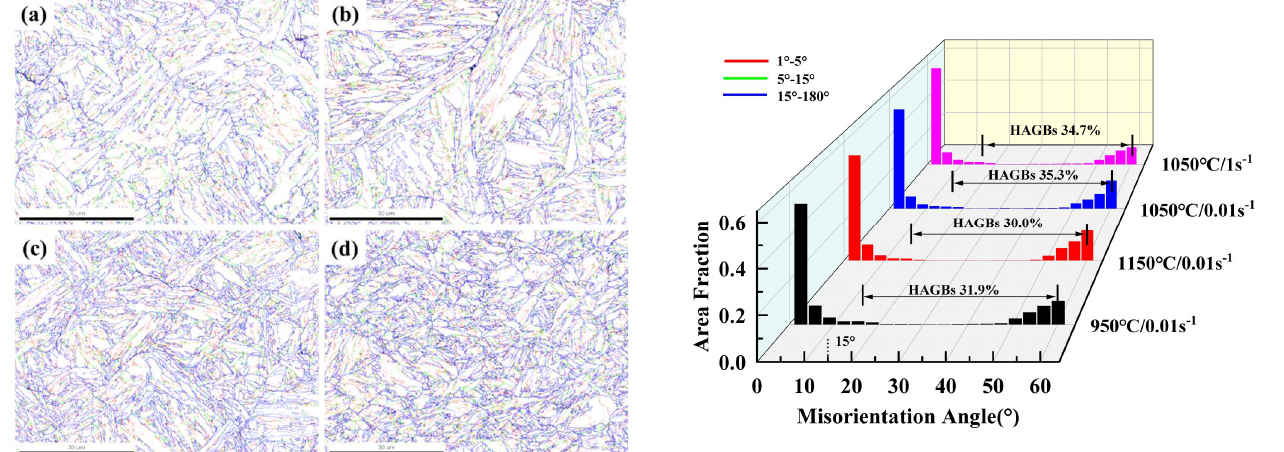
Figure 7. Boundary maps of 18CrNiMo7-6 alloy steel ( a ) 950 °C/0.01 s −1 ; ( b ) 1150 °C/0.01 s −1 ; ( c ) 1050 °C /0.01 s −1 ; ( d ) 1050 °C/1 s −1 .